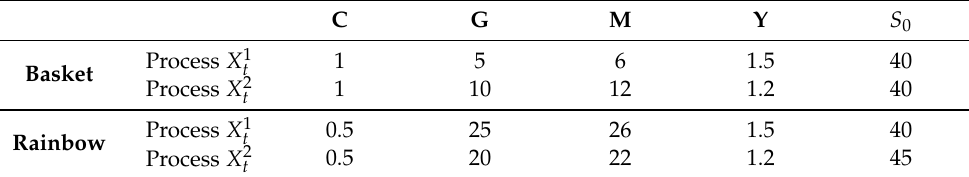
Figure 1. EE , PFE 97.5% , and PFE 2.5% of the basket and rainbow options, comparison of the MC-ADI and MC-CC methods. Table 2. Parameter setting for basket options and rainbow options.